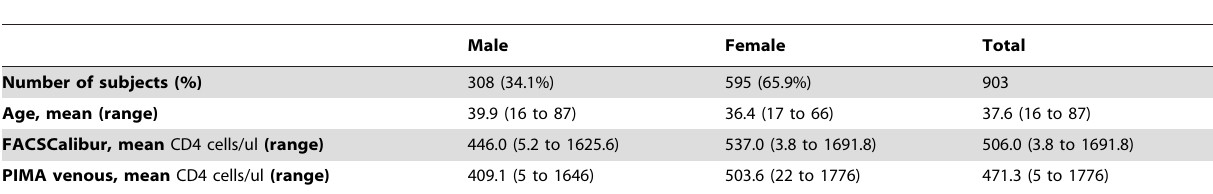
Table 2. Bias results of PIMA Venous versus FACSCalibur measurements.